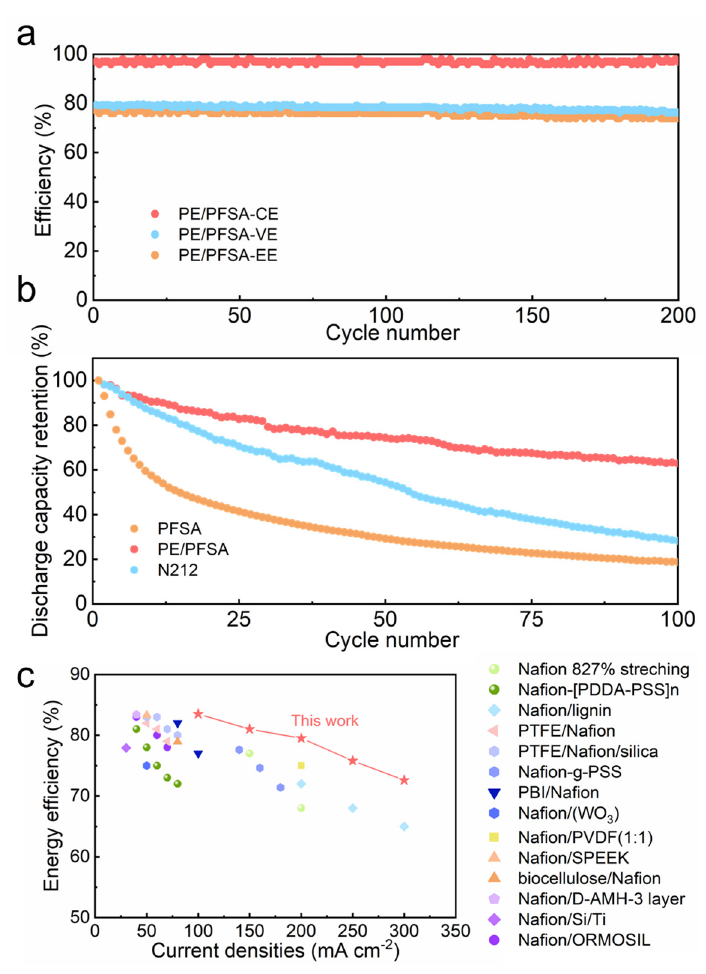
Figure 6. ( a ) Comparison of cycle efficiencies of the three membranes at 200 mA cm − 2 ; ( b ) discharge capacity retention of the pure PFSA, PE/PFSA composite, and Nafion212 membranes; and ( c ) EE comparison between PE/PFSA and other existing advanced membranes at different current densi- ties [7,26,33–44].